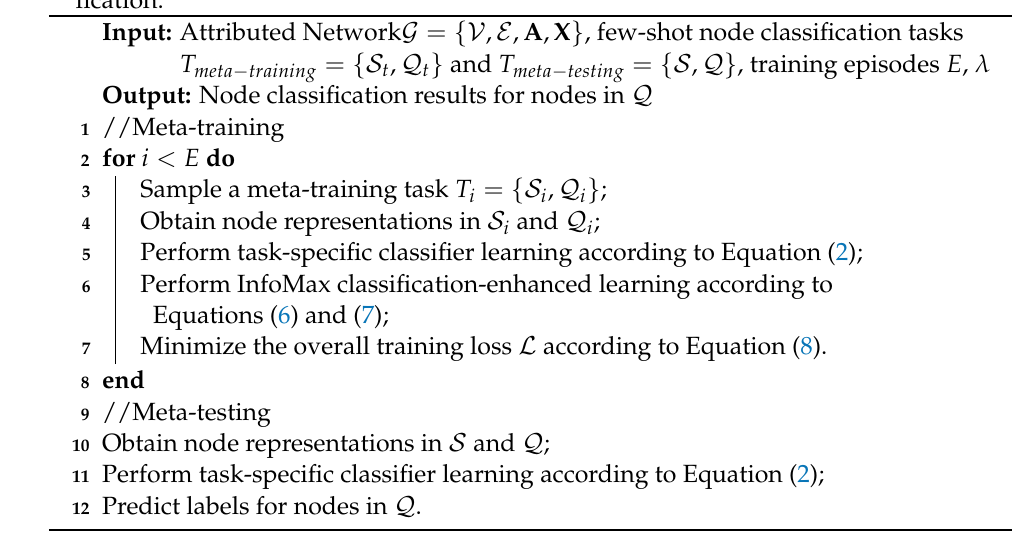
Algorithm 1: The detailed ICELN learning framework for few-shot node classi-